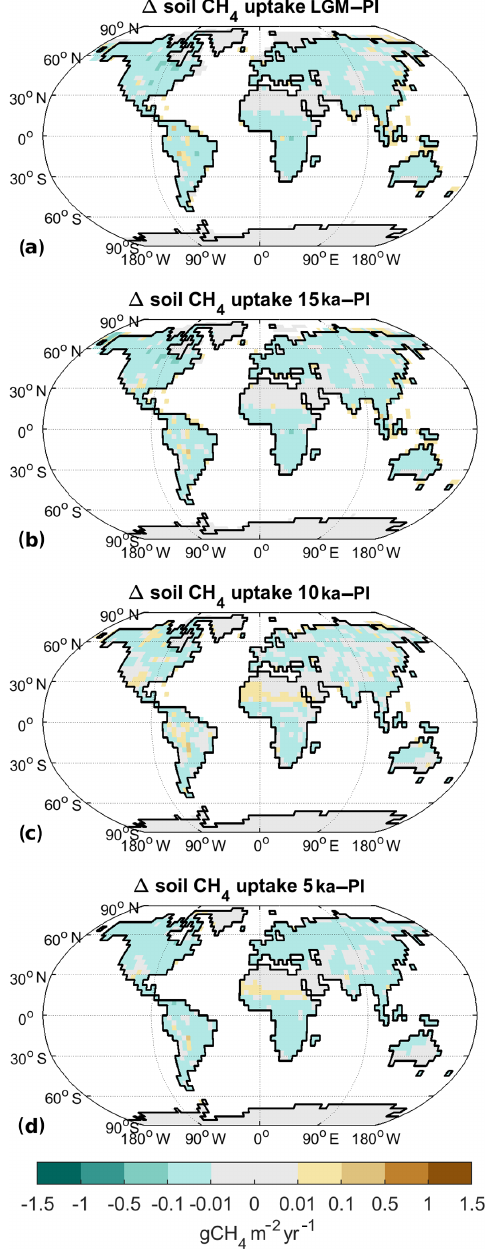
Figure 8. Difference in termite methane emissions to preindustrial for (a) LGM, (b) 15ka, (c) 10ka, and (d) 5ka.